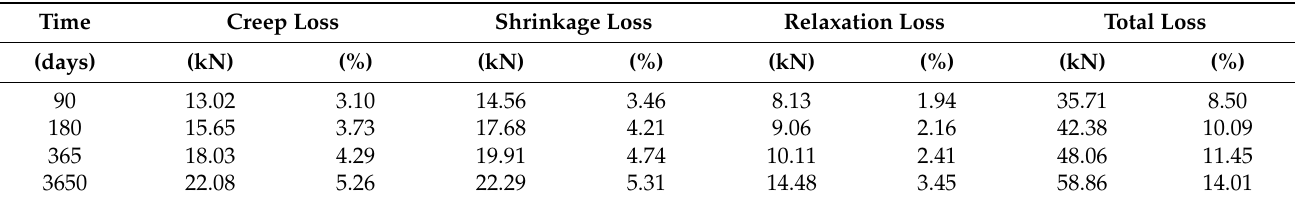
Table 4. Loss of prestress in railway sleepers due to time-dependent behaviour.